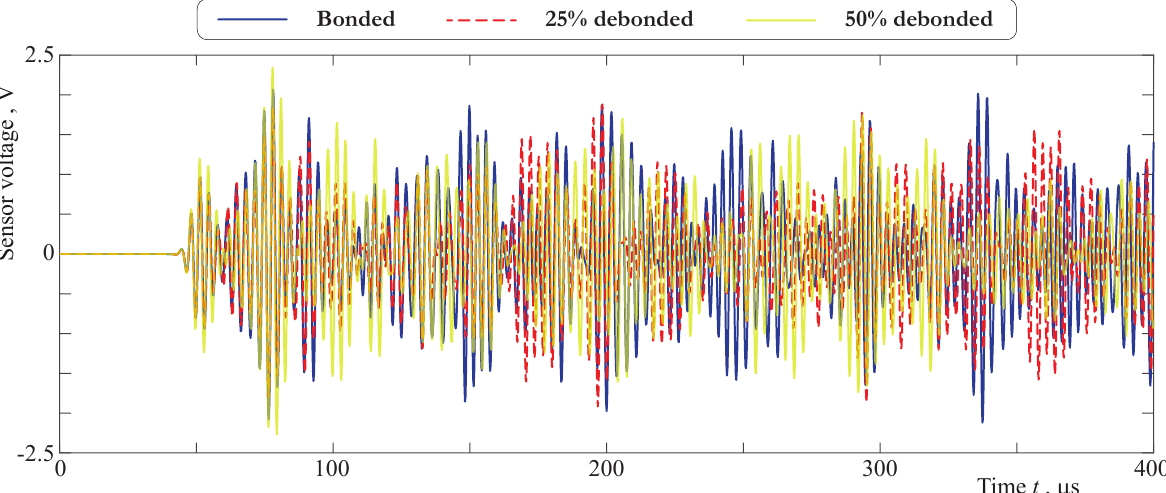
Figure 17. Voltage signals obtained from the sensor for debonding rates of 0%, 25%, and